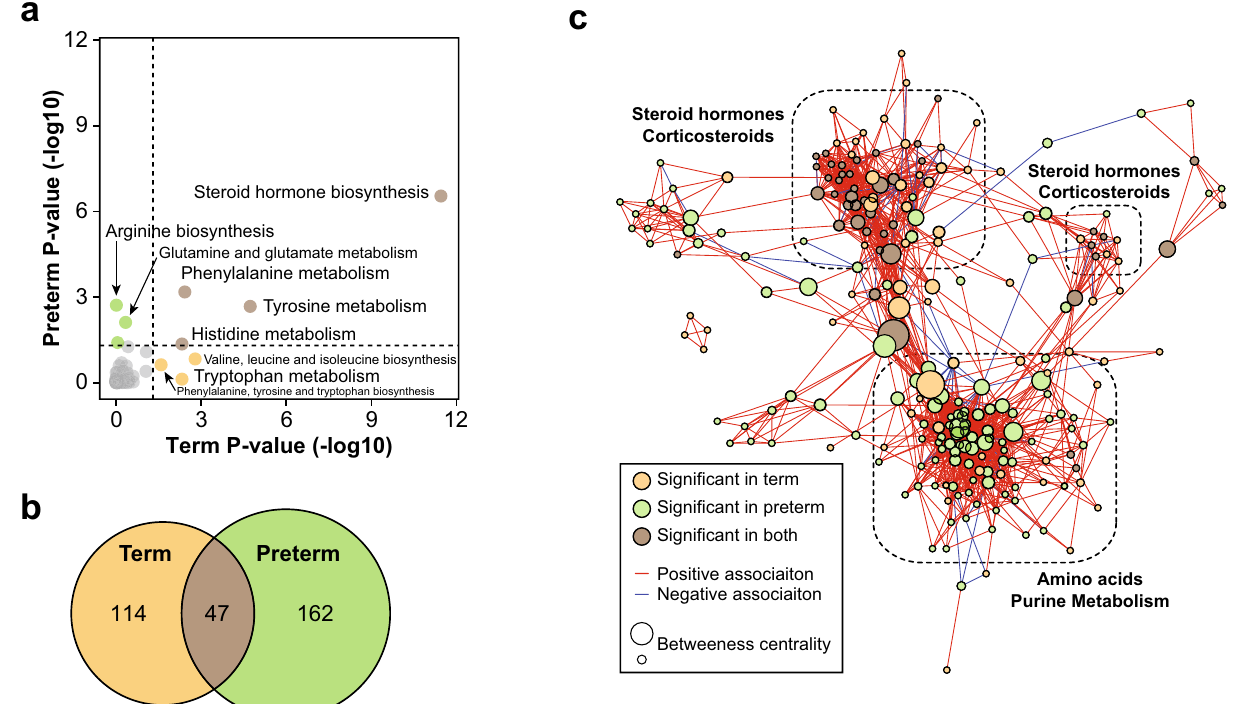
Figure 4. Biological processes associated with term and preterm prediction models. ( a ) KEGG metabolic pathway enrichment analysis using metabolites selected in the term and preterm RF models ( P -value < 0.05). ( b ) Venn diagram of validated metabolites predictive of GA ( P -value < 0.05) in term and preterm models. ( c ) Pairwise spearman correlation network. Nodes were color-coded by model significance and their size represents the betweenness